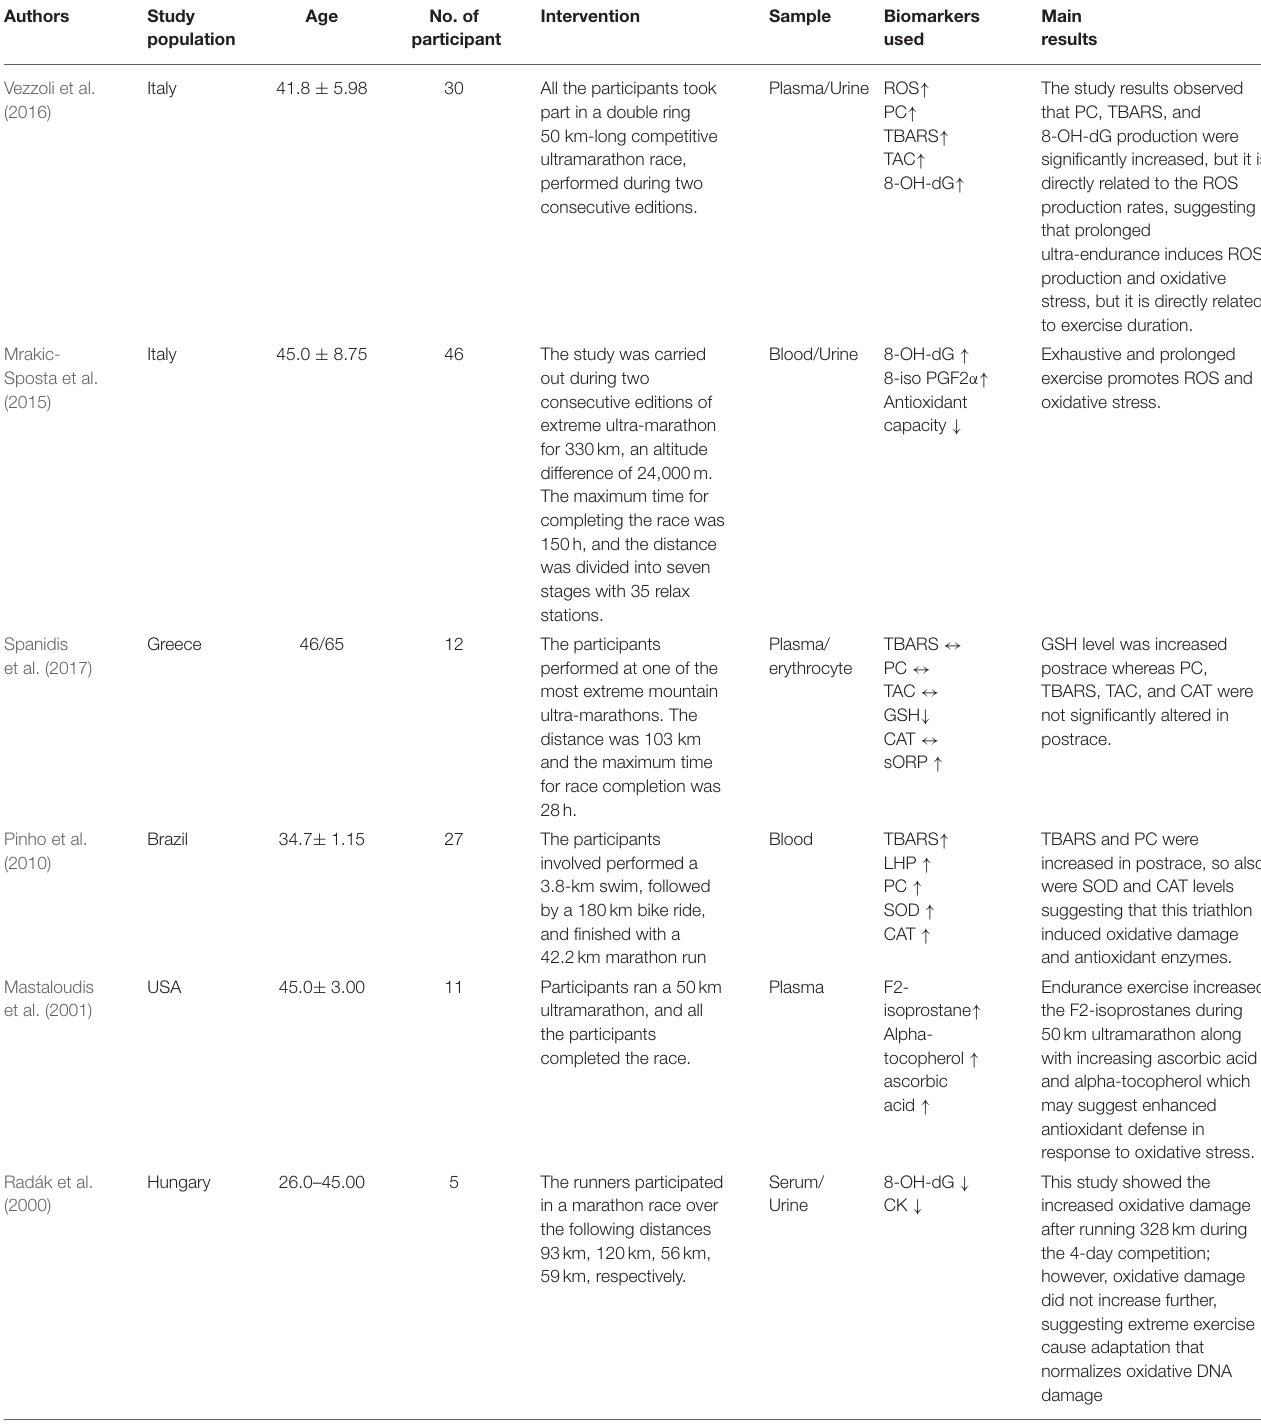
TABLE 1 | The study characteristics of included